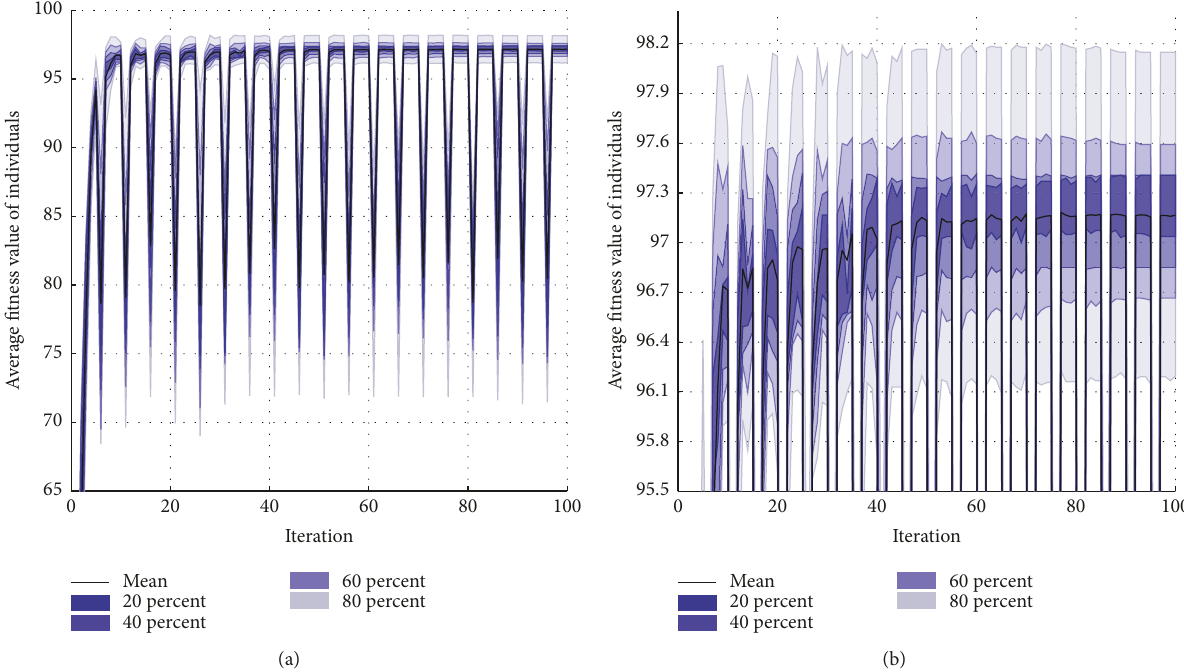
Figure 8: Convergence procedure of proposed optimization approach: (a) overall trend, (b) partial enlarged detail.